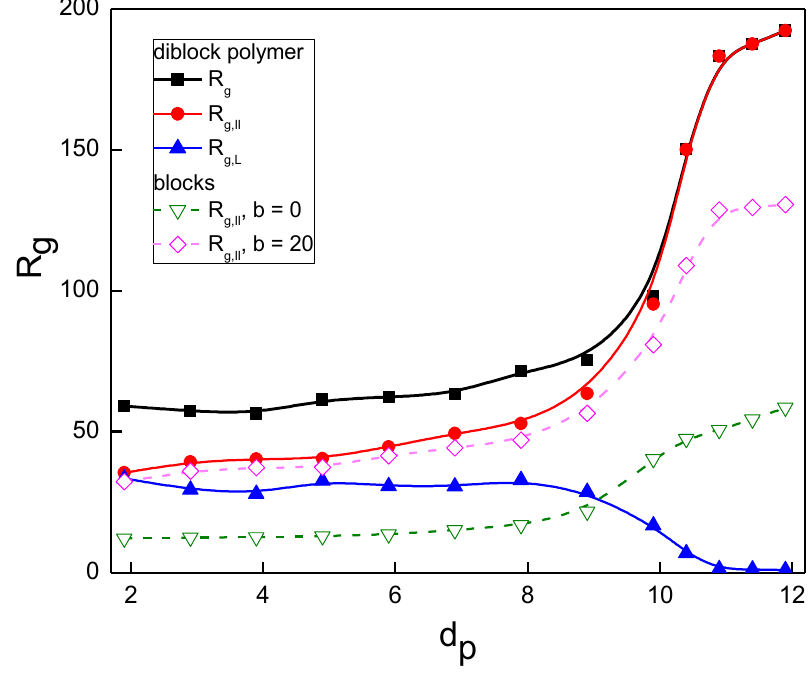
Figure 5. The radius of gyration of a diblock copolymer and its components parallel and perpendicular with the nanoposts. The parallel component of the radius of gyration for individual blocks is shown by the dashed lines.